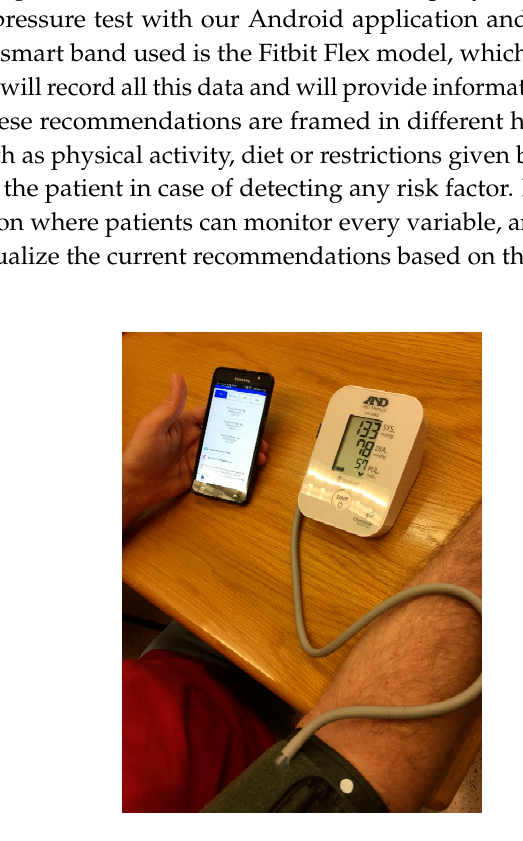
Figure 8. Patient monitoring system sensing blood pressure.